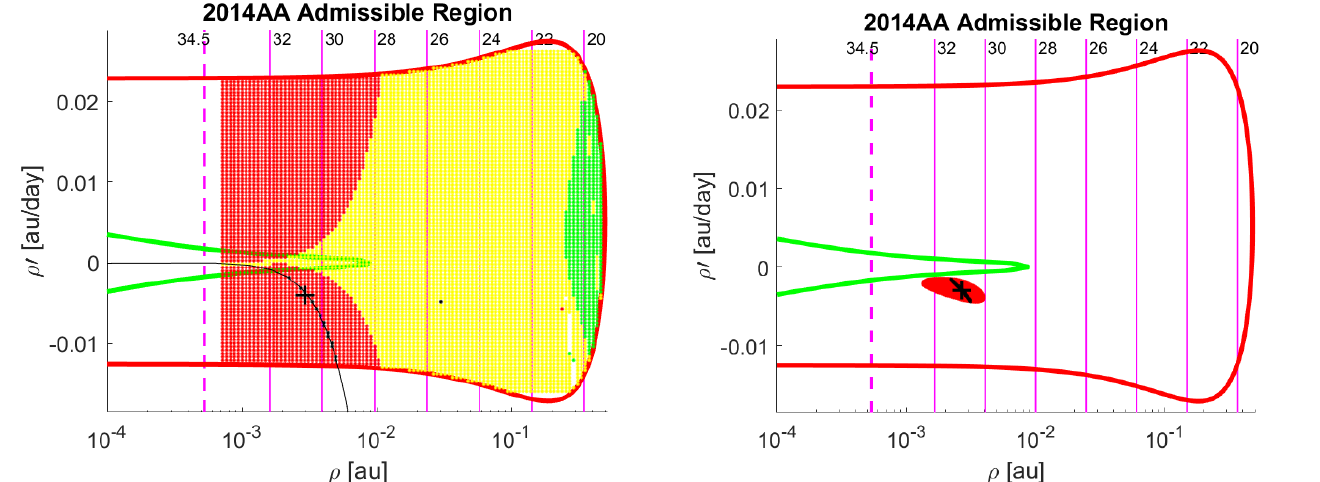
Figure 2. Tool 1 tested on tracklets of three observations (left) and seven observations (right) for asteroid 2014AA.